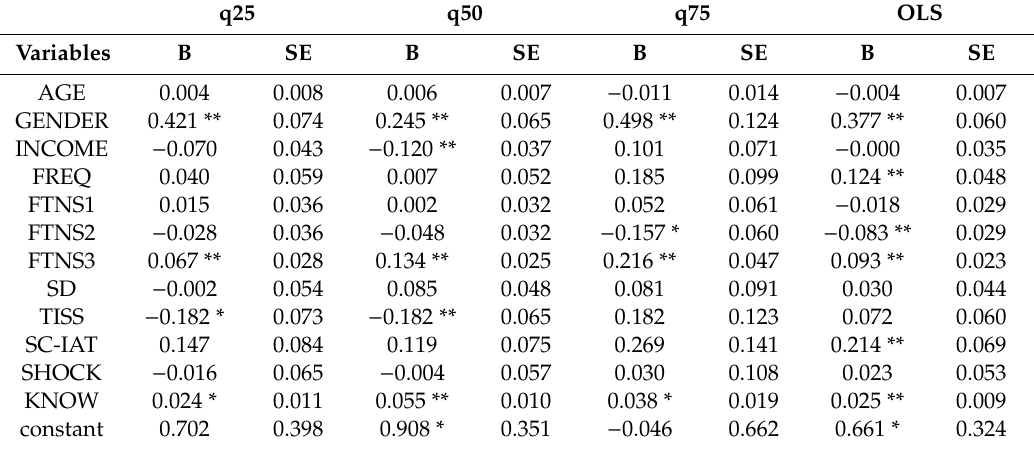
Table 6. Estimated regressions for the conventional product ( n =